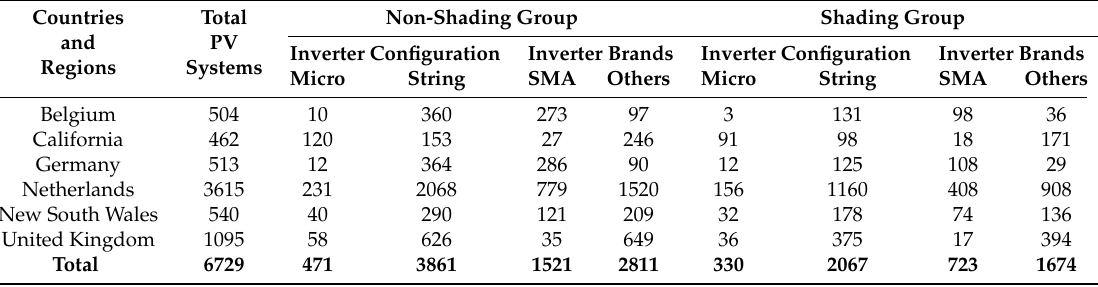
Table 2. Summary of the rooftop PV systems in our study. The dataset was collected in August 2018. Countries and